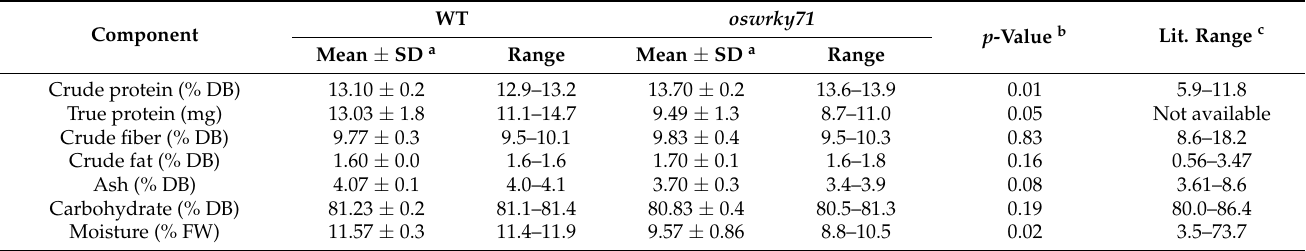
Table 1. Comparison of the proximate composition of threshed rice grain.